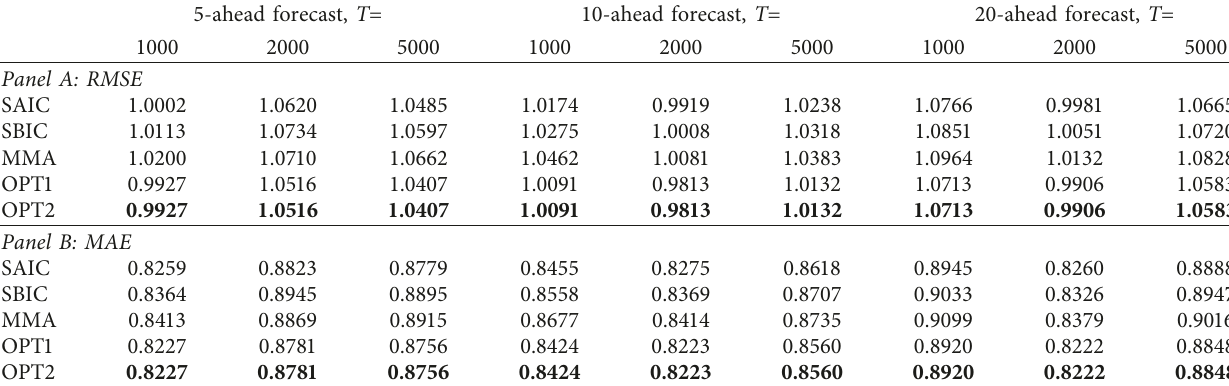
Table 1: Out-of-sample forecasting results for simulation